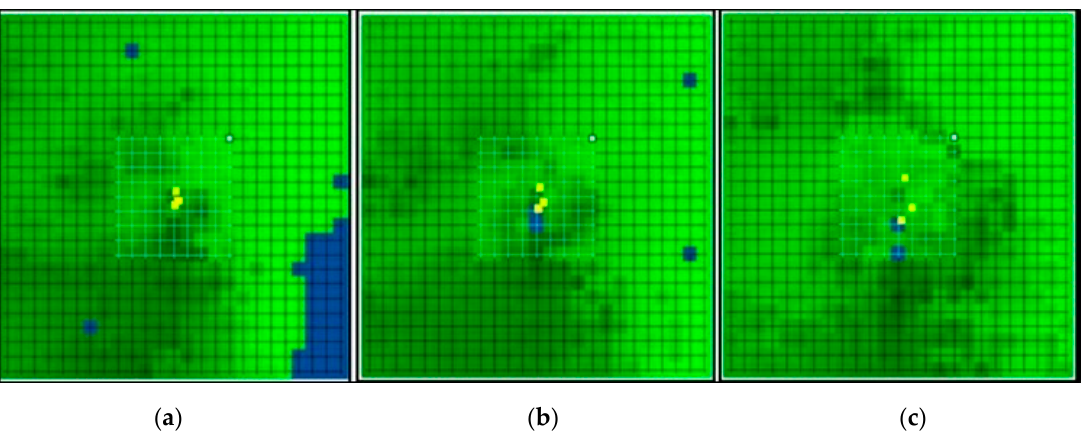
Figure 2. The horizontal grid domain used by TAPM for meteorology and the smaller grid for PM 10 predictions (25 × 25). These domains were simulated at horizontal grid resolutions of ( a ) 30 km, ( b ) 20 km, ( c ) 10 km and 4 km for PM 10 emissions.